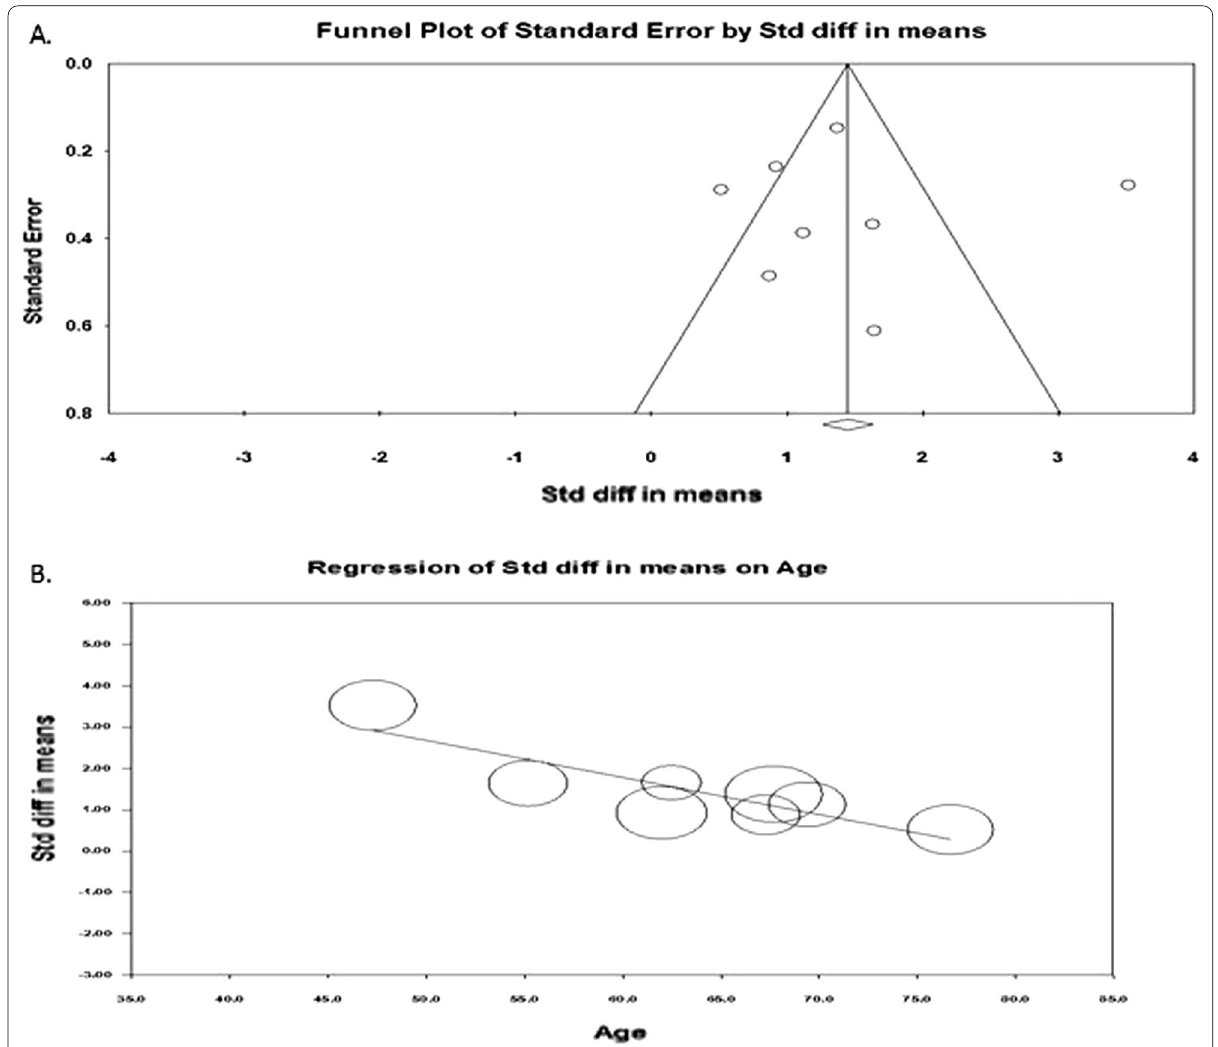
Fig. 3 Publcation biasl ( A ) and regressin analysis ( B ) of effect size on age